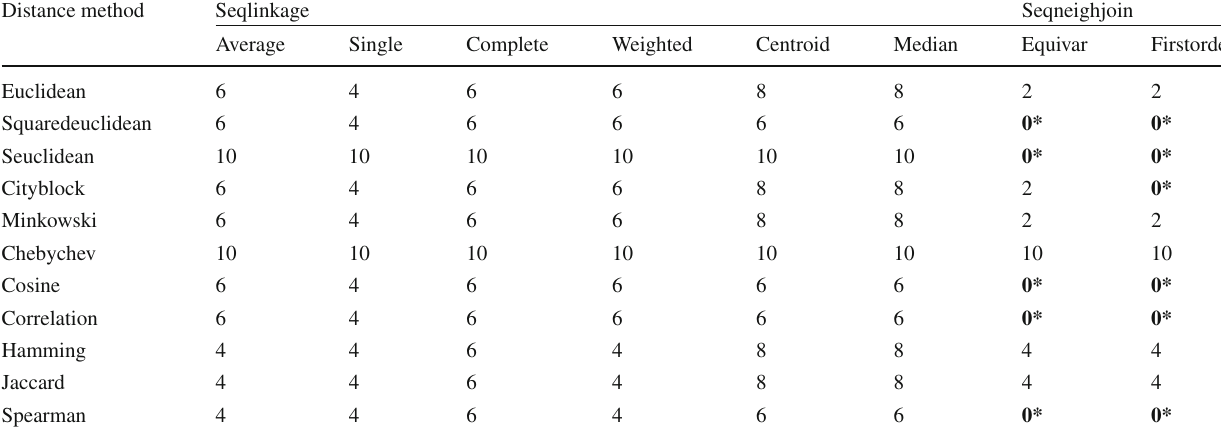
Correlation Hamming